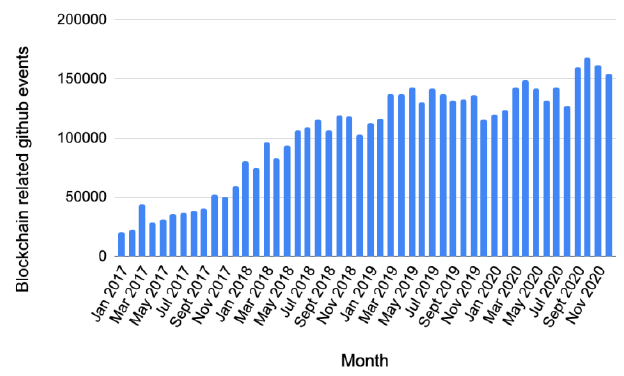
Figure 17: GitHub Blockchain-related code repository